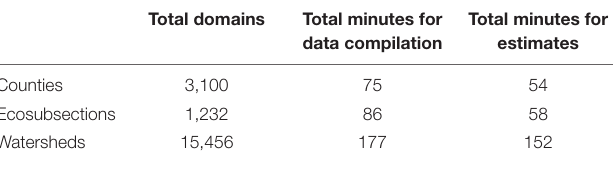
TABLE 2 | Processing times for generating eight different estimates for five response variables across the three national